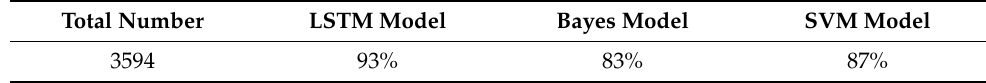
Figure 9. ROC curves for the case of the current lane having a car in front of the vehicle. The support vector machine (SVM) algorithm and Bayesian classification algorithm were used for comparison, as shown in Table 3. Table 3. Model recognition accuracy. SVM: support vector machine. Table 3. Model recognition accuracy. SVM: support vector machine.